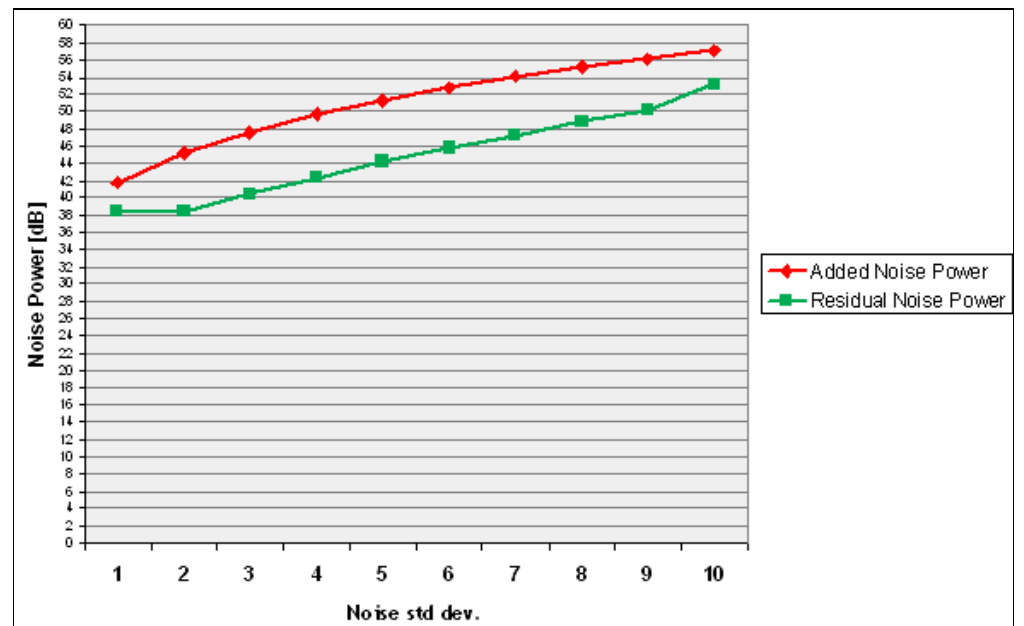
Figure 12. Noise power test. Upper line: noise level before filtering. Lower line: residual noise power after filtering.